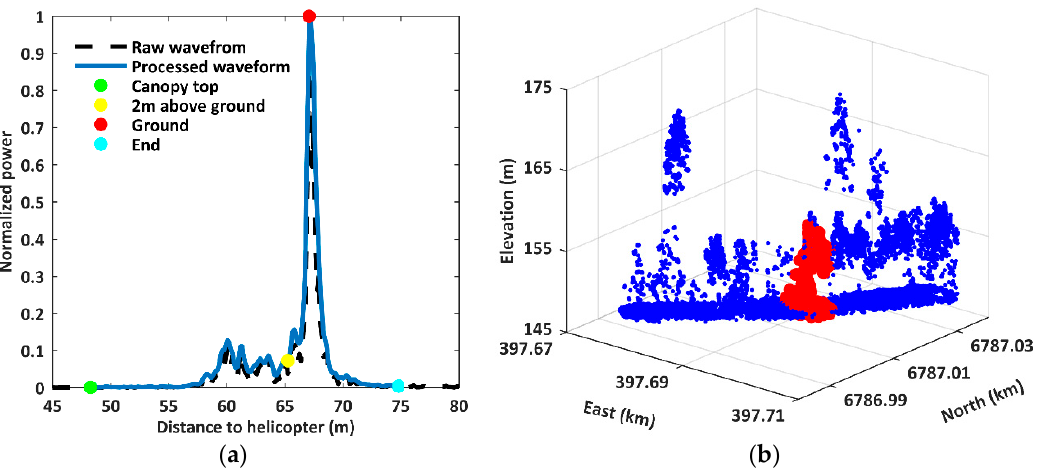
Figure 8. The Tomoradar waveform and the LiDAR data at the 5270th measurement: ( a ) Tomoradar normalized power waveform and processed results; and ( b ) the LiDAR point cloud within the Tomoradar cone (red color) and neighboring ones (blue color).